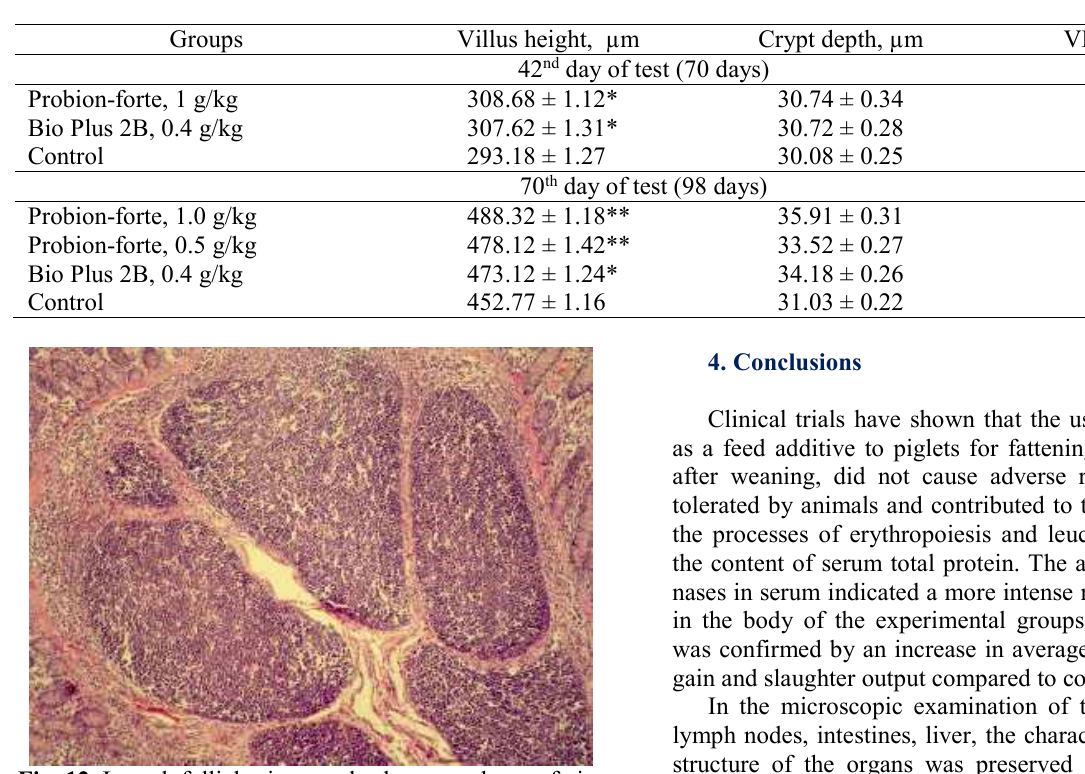
Fig. 12. Lymph follicles in caecal submucous layer of pig- lets from the 1 st group, 70 nd day of test. H&E. x 100